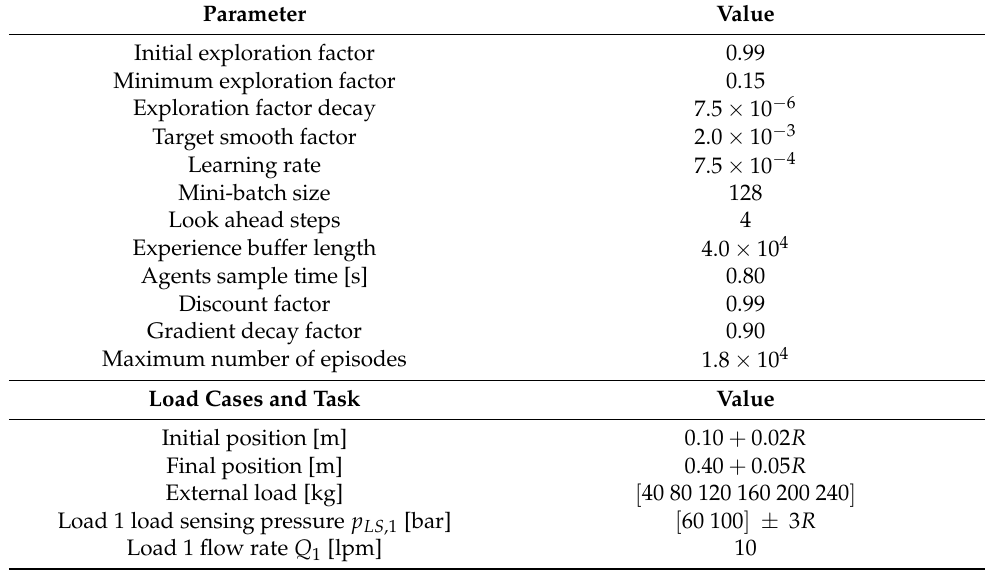
Table 3. Agent and task parameters.